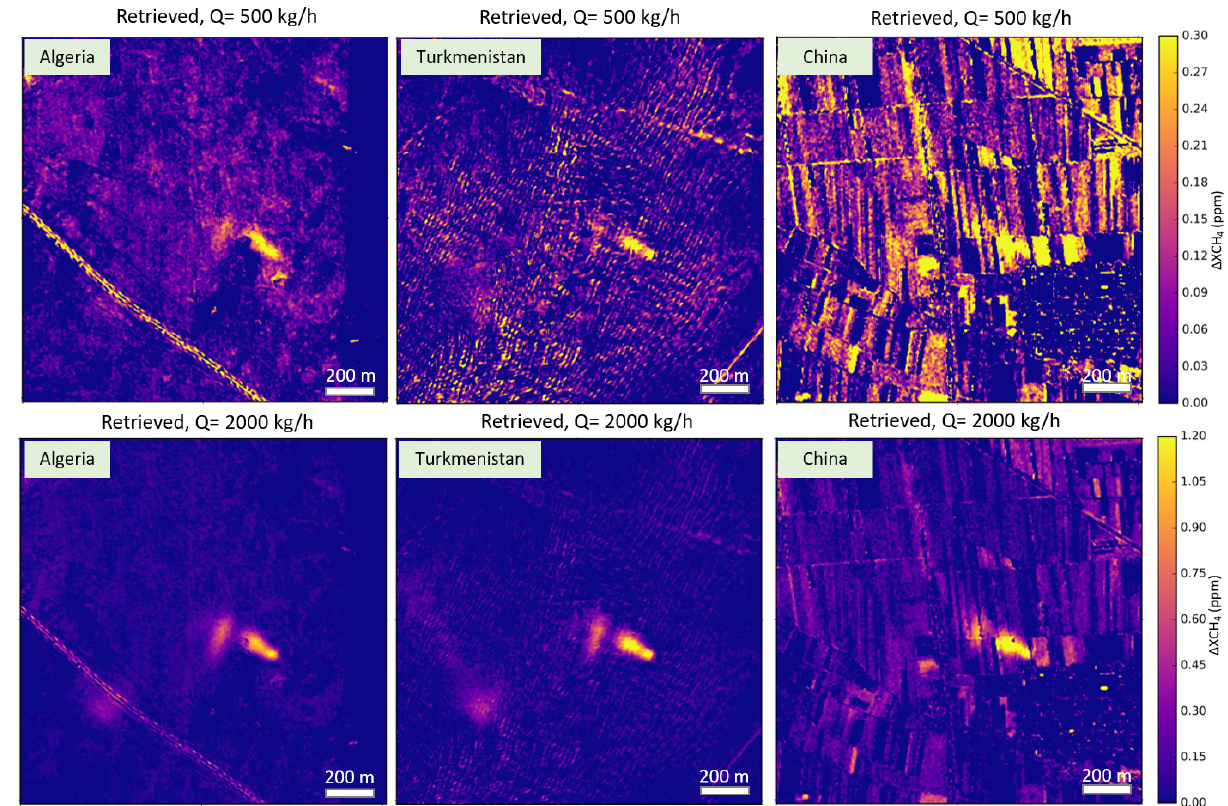
Figure 7. (cid:49) XCH 4 maps for the simulations at the three different sites analyzed (same subsets as Figs. 5 and 6) and two values of emission flux rate Q 500kgh − 1 and Q 2000kgh − 1 .